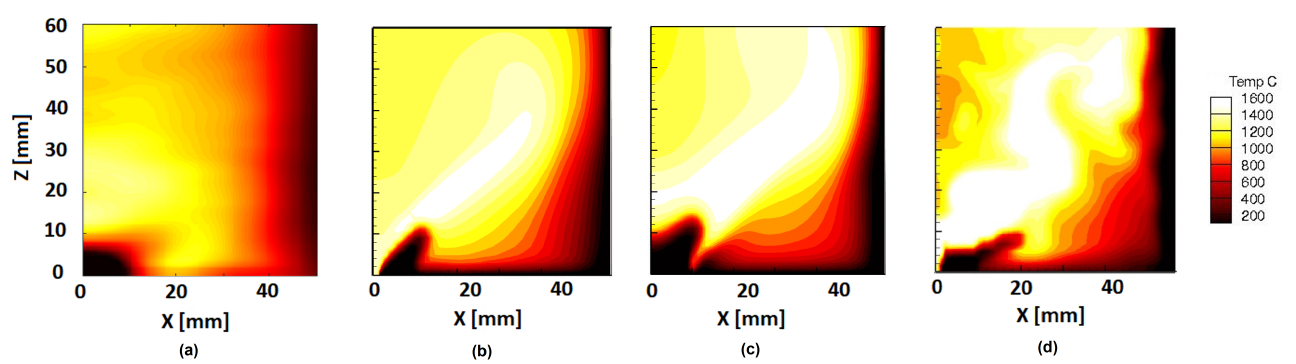
Figure 10. Flow comparison-temperature profile shown for ( a ) experiments, ( b ) FGM premixed with RNG k- (cid:101) , ( c ) FGM premixed with k- ω and ( d )